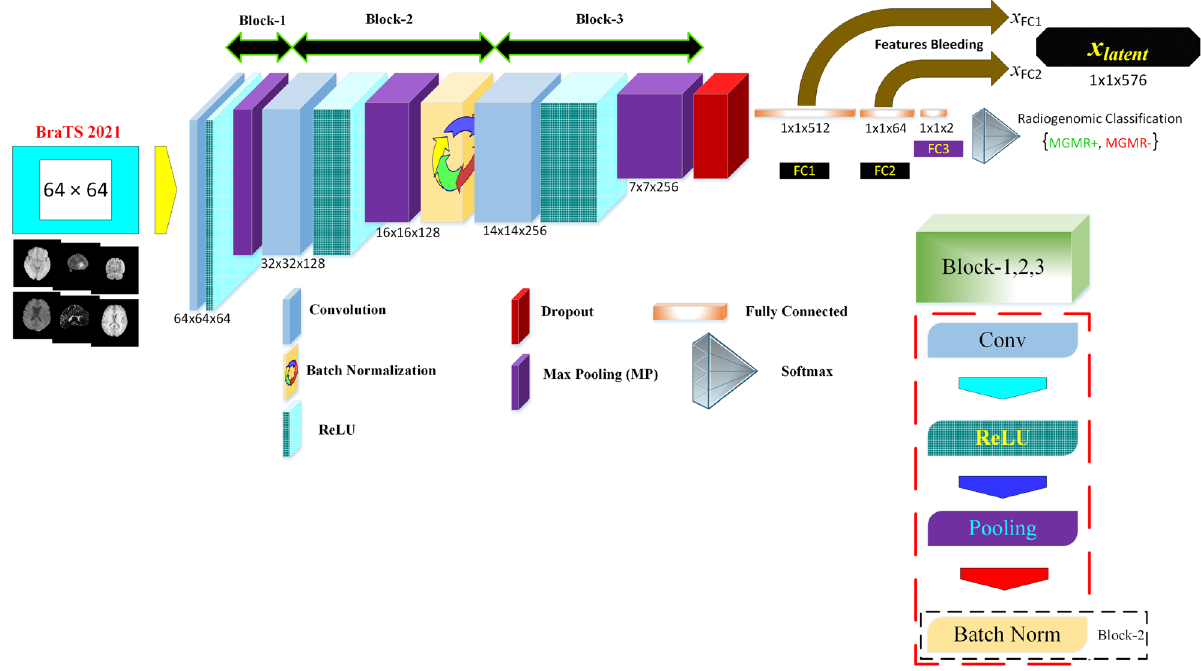
Figure 5. Latent feature extraction x latent using DLRFE-module via feature-bleeding through fully connected